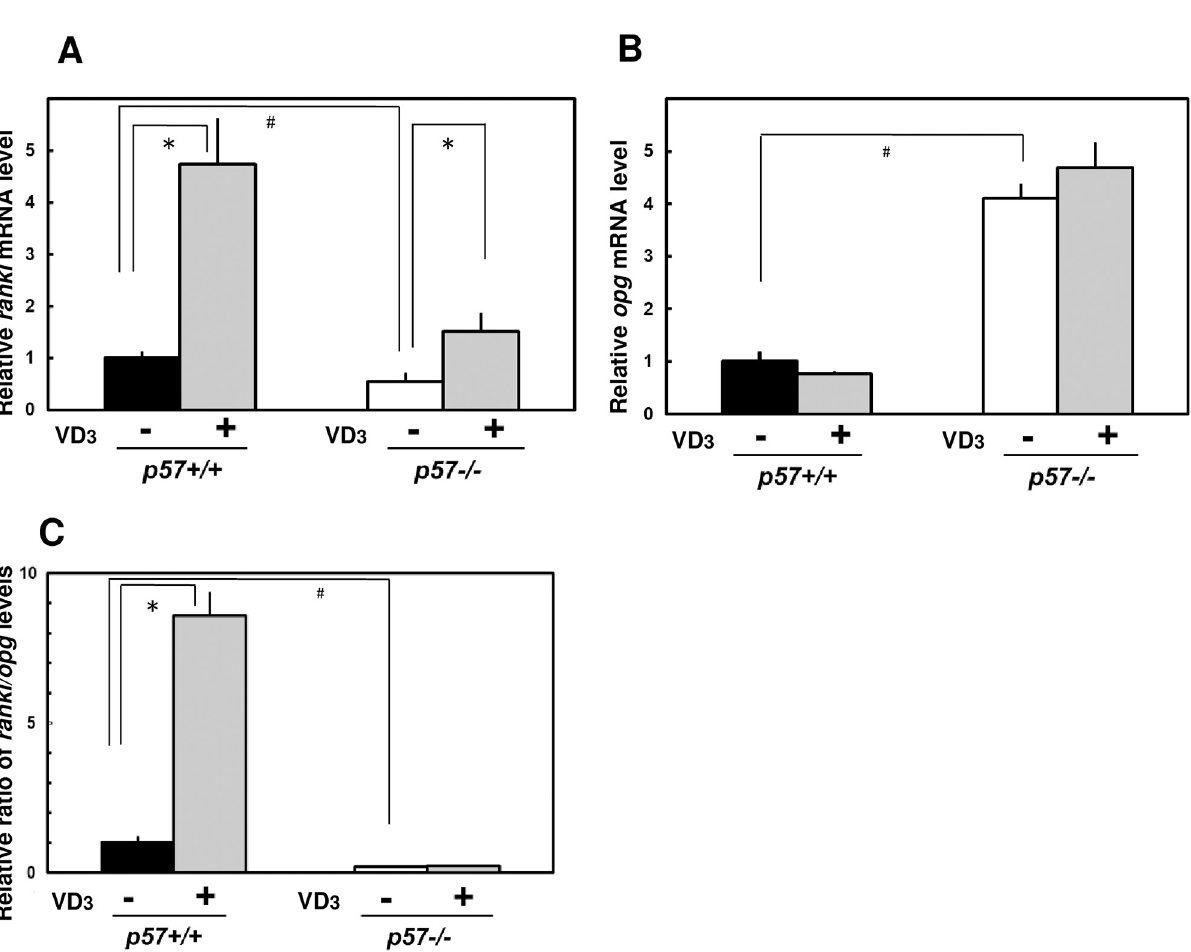
Fig 4. VD 3 -induced rankl expression in osteoblasts depended on p57 Kip2 . (A) Quantitative RT-PCR analysis of the levels of the rankl mRNA in osteoblasts treated with 0.1% ethanol (-) or 10 nM 1,25-(OH) 2 VD 3 (+) for 72 h. Levels of the rankl mRNA were normalized to the mRNA levels of the constitutive gene hprt1 . (B) Quantitative RT-PCR analysis of the expression of the opg mRNA in osteoblasts treated with 0.1% ethanol (-) or 10 nM 1,25-(OH) 2 VD 3 (+) for 72 h. Levels of the opg mRNA were normalized to the mRNA levels of the constitutive gene hprt1 . (C) The relative ratio of the rankl mRNA/ opg mRNA was calculated and compared between p57+/+ and p57-/- osteoblasts. In the graphs, relative levels in p57+/+ cells were estimated. The # symbol indicates a statistically significant difference between p57+/+ and p57-/- cells: #, p < 0.01. The asterisk indicates a statistically significant difference between 0.1% ethanol (-) and 10 nM 1,25-(OH) 2 VD 3 (+): � , p < 0.01.